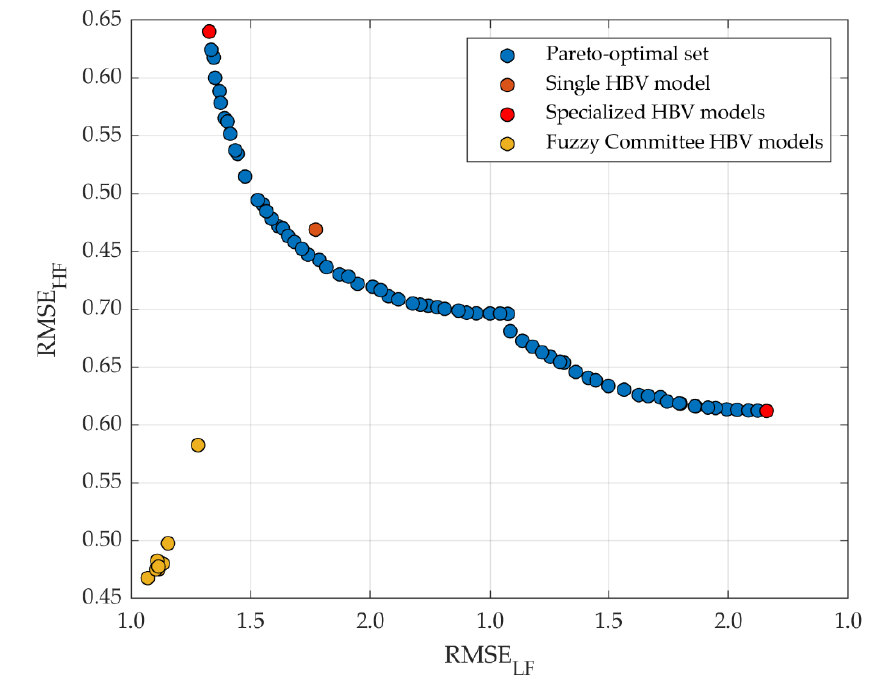
Figure 7. Modular rainfall-runoff models compared to a single HBV model and local models.